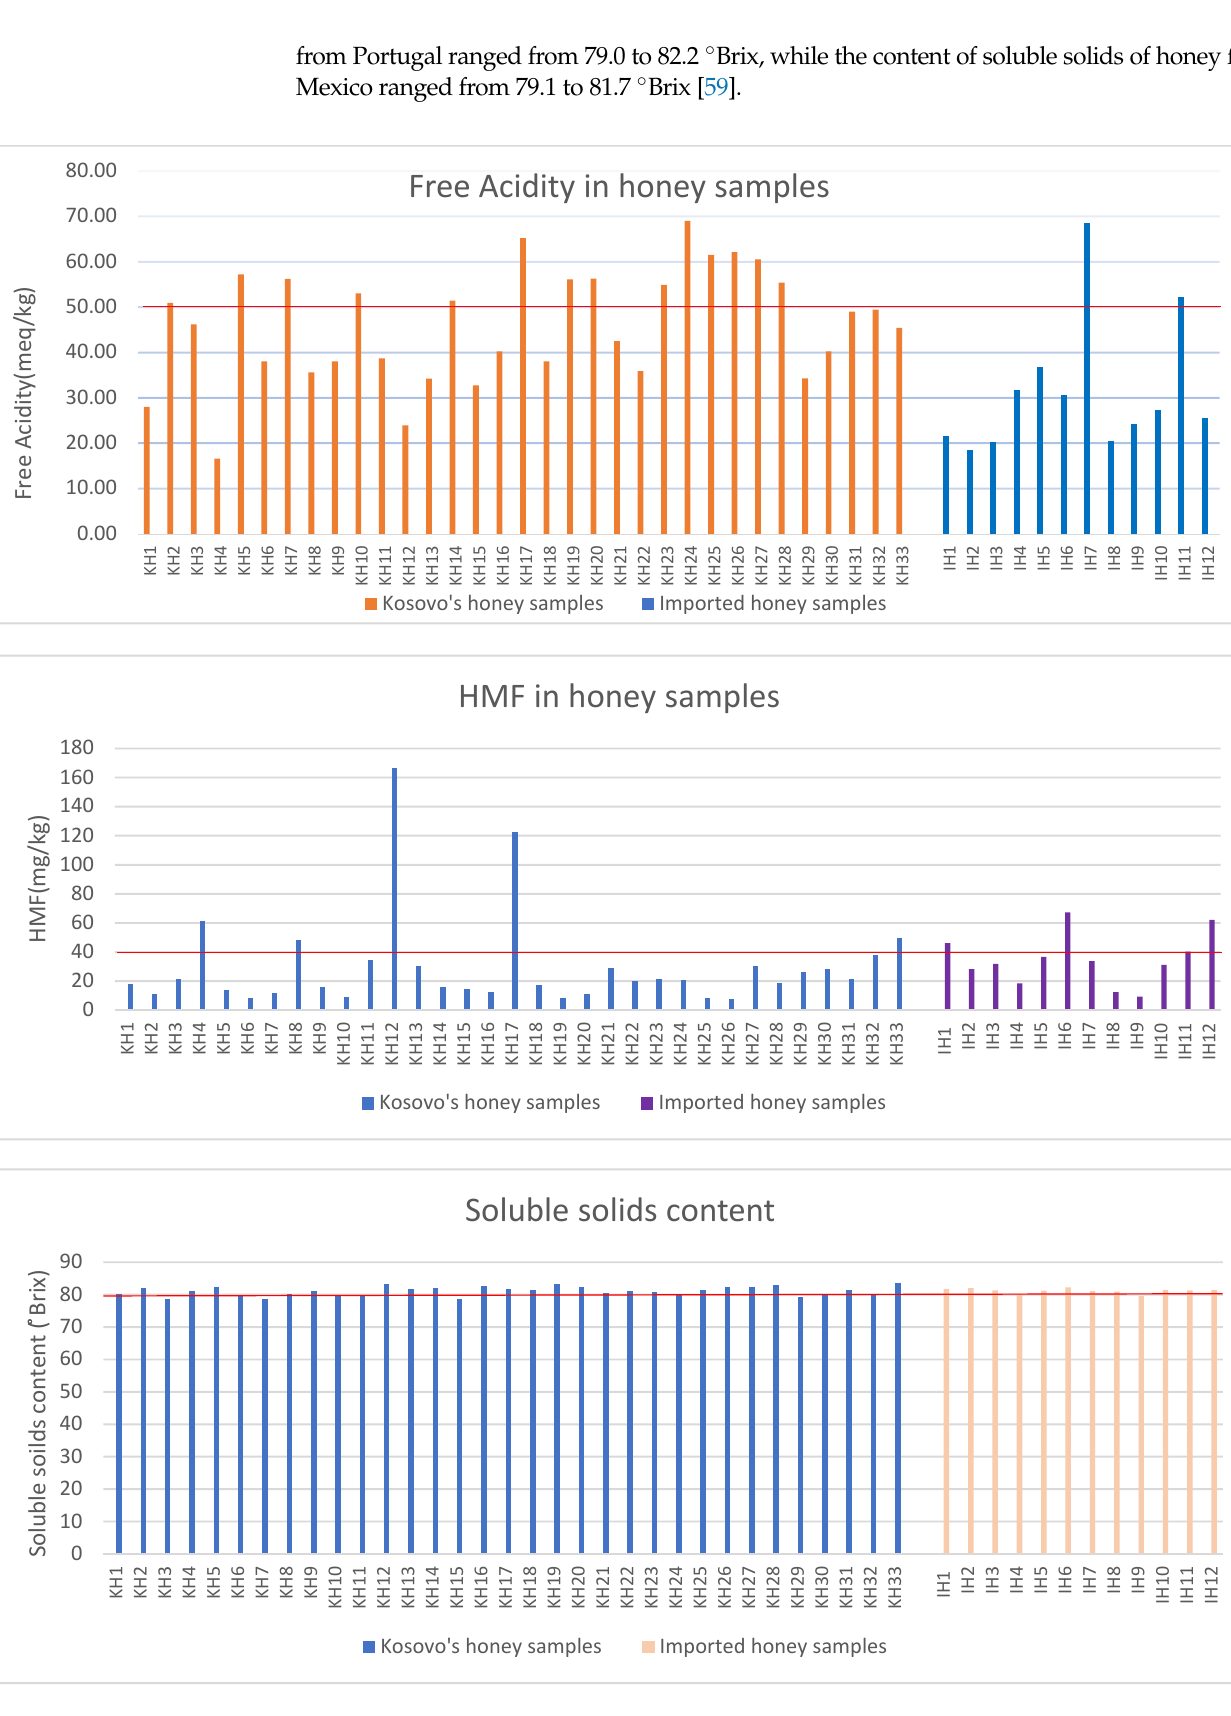
Figure 2. Summary of the values shown for free acidity, HMF, and soluble solids.